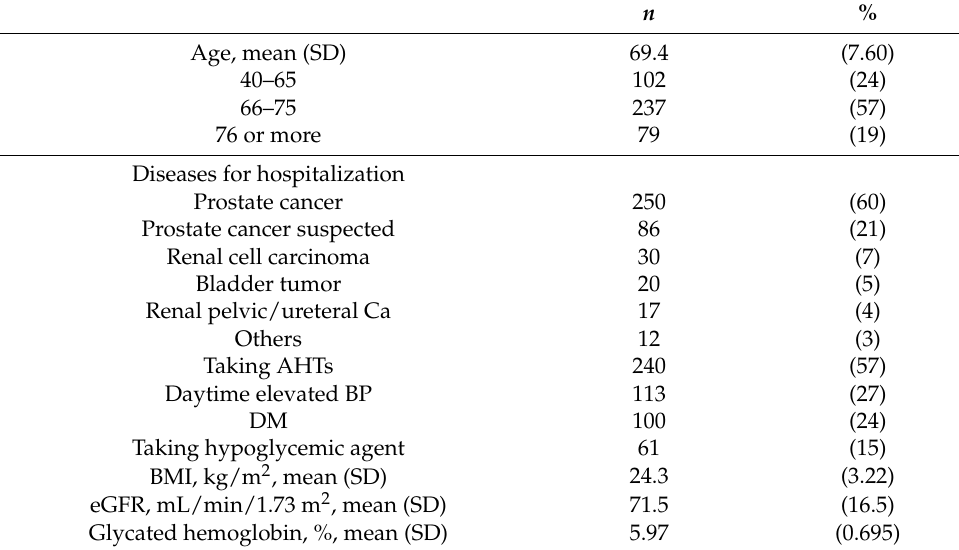
Table 1. Patients’